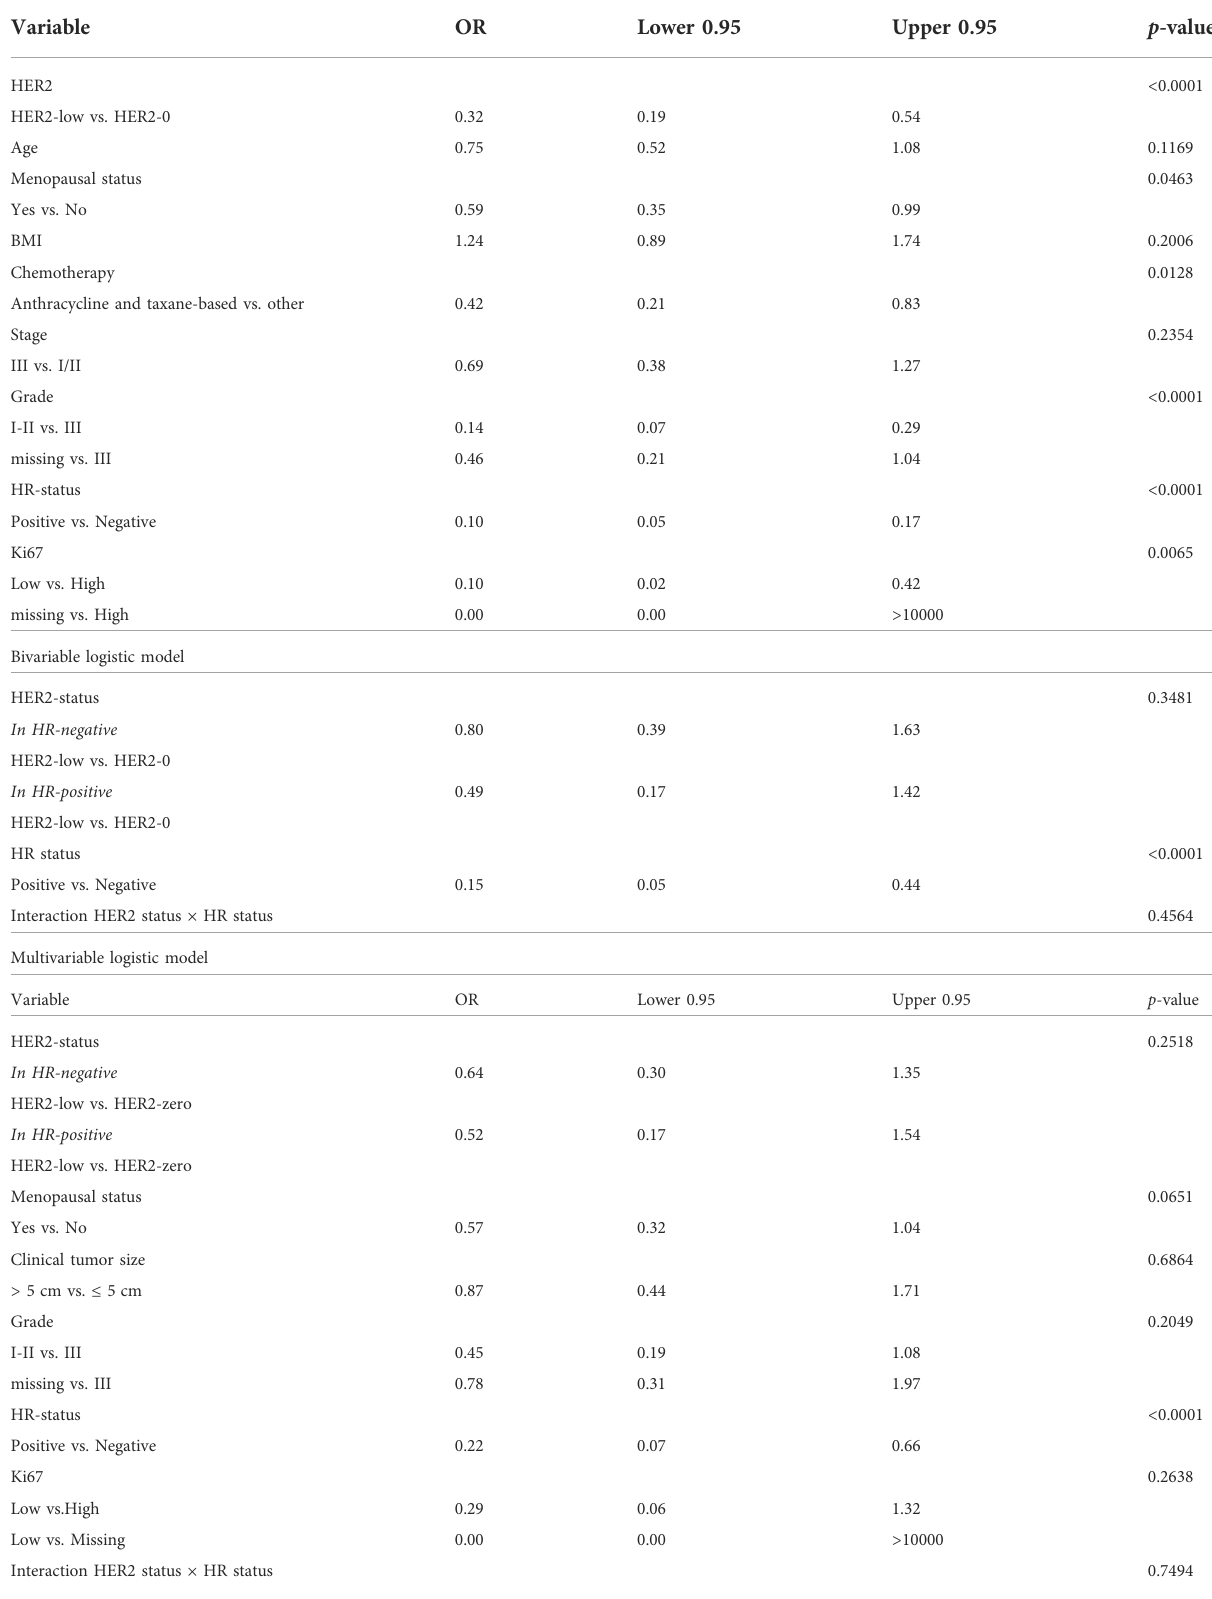
TABLE 2 Association between clinical-pathological variables and pathological complete response in the overall study